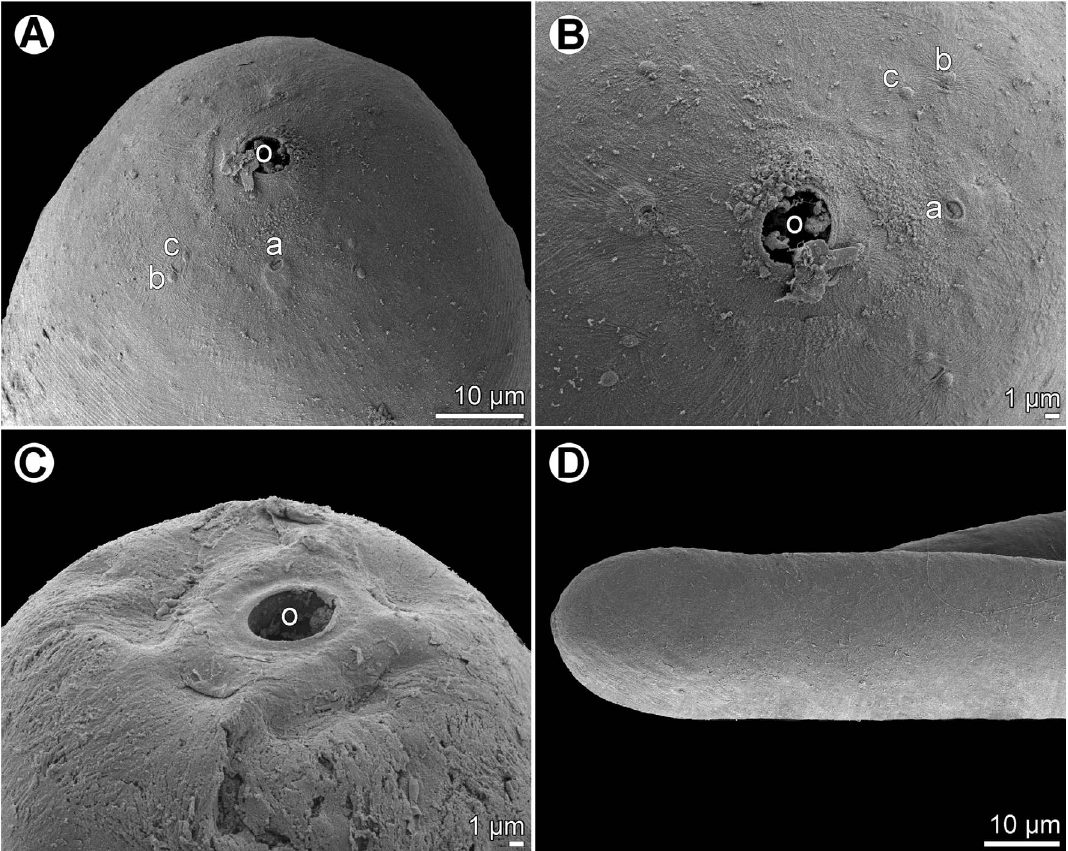
Figure 2. Ichthyo fi laroides novaecaledoniensis (Moravec et Justine, 2009) n. comb., scanning electron micrographs of gravid female. (A) Cephalic end, subapical view; (B) region of oral aperture, apical view; (C) cephalic end (another specimen), subapical view; (D) tail end of specimen without terminal caudal projection. (a) Amphid; (b) submedian cephalic papilla of outer circle; (c) submedian cephalic papilla of inner circle; (o) oral